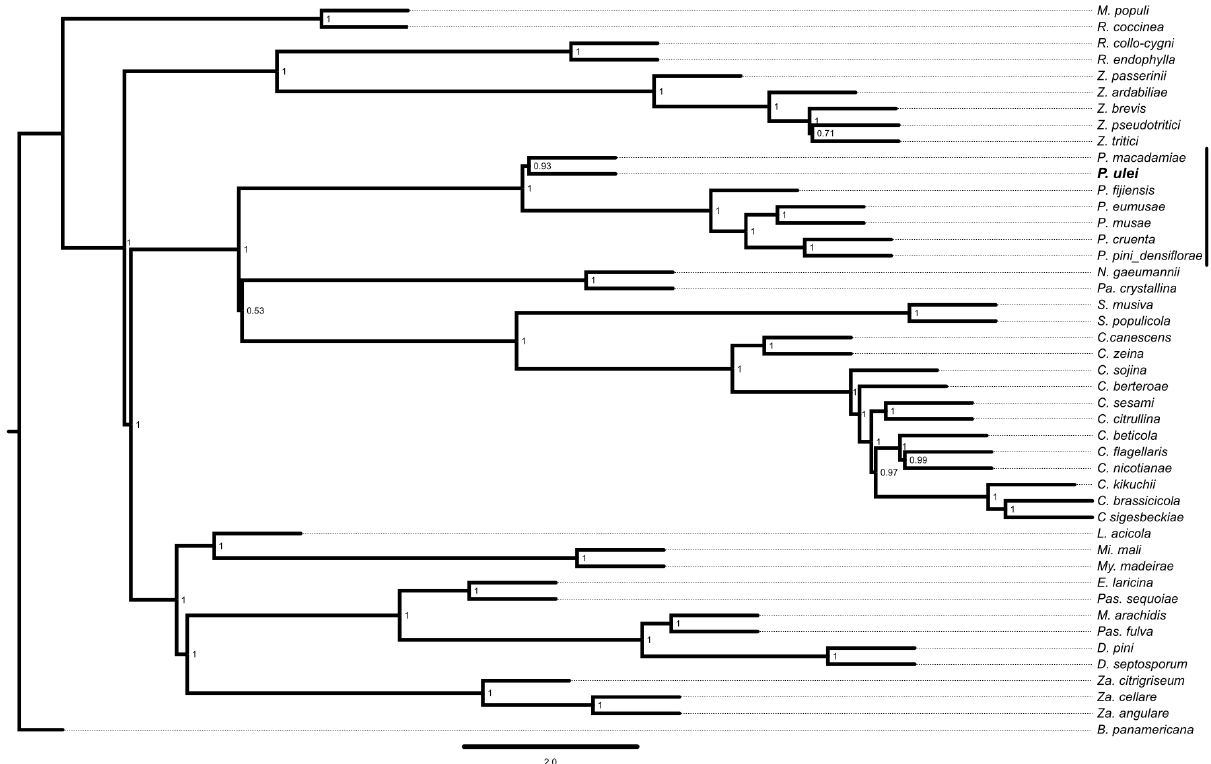
Figure 2 – Phylogenetic inference of members of Mycosphaerellaceae for which genome sequences are available (see Table S5 for the genome accession number for each species). Phylogenetic tree inferred with a supertree approach using Astral, using the protein sequences of 1,315 orthologous genes identified by BUSCO. Individual gene trees were inferred with IQ-Tree. P. ulei appears in bold face. Member of the genus Pseudocercospora are identified by a vertical black